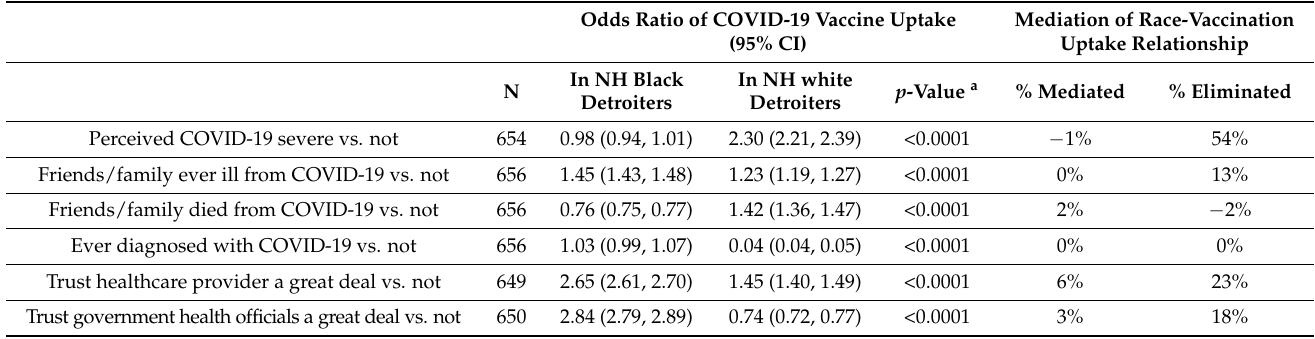
Table 4. Odds of vaccine uptake by COVID-19 experiences and trust in healthcare providers and authorities, in NH Black and NH white Detroiters in the Detroit Metro Area Community Study, October 2020 and June